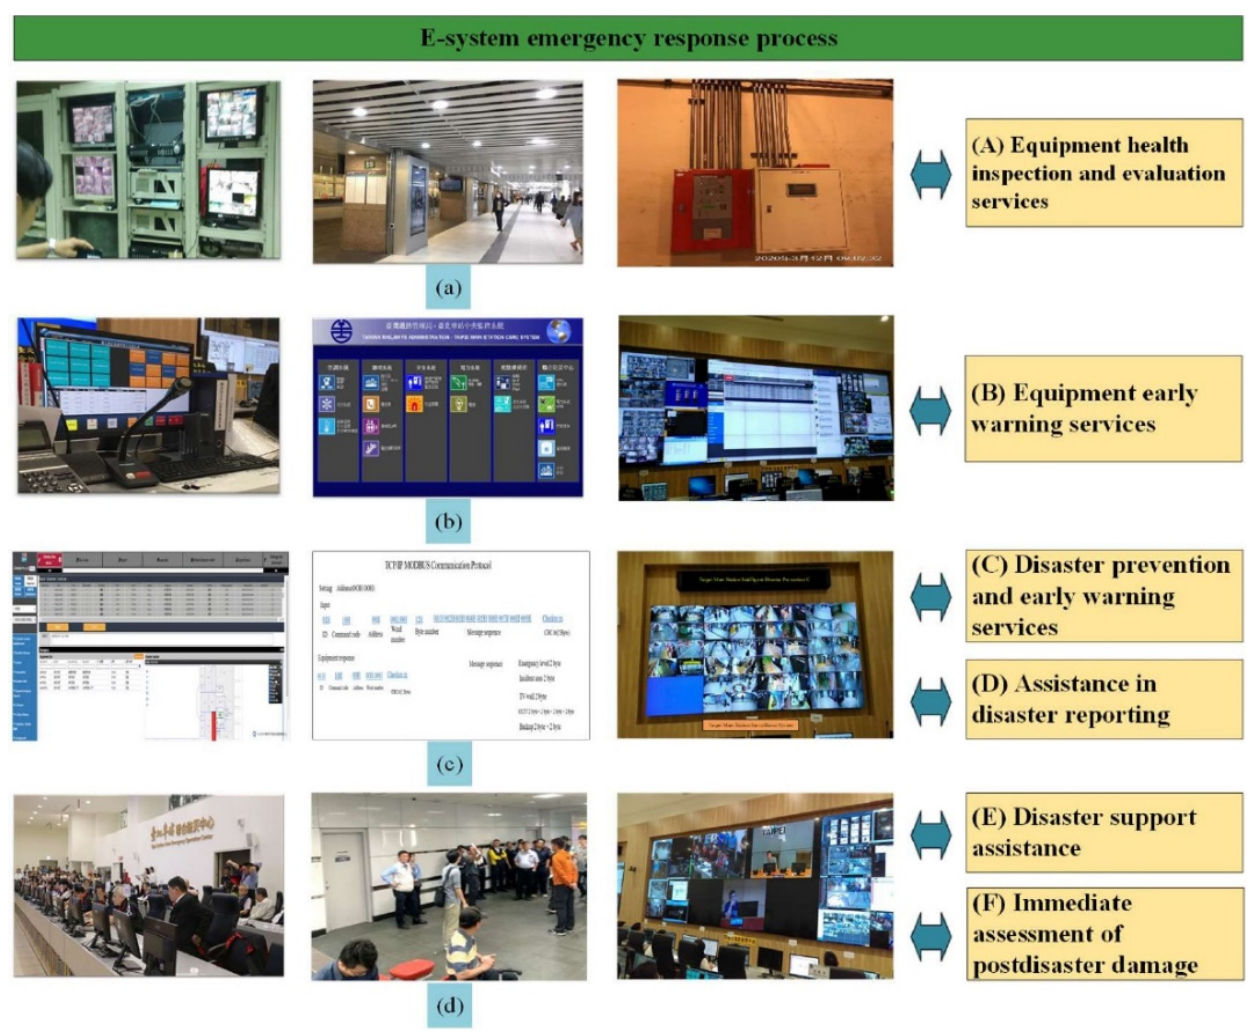
Figure 15. E-system emergency response process. (Source: Research Data). ( a ) Condition inspection and repair module; ( b ) Monitoring and remote transmission module; ( c ) Real-time monitoring and security analysis module; ( d ) Early warning reporting and disaster relief support